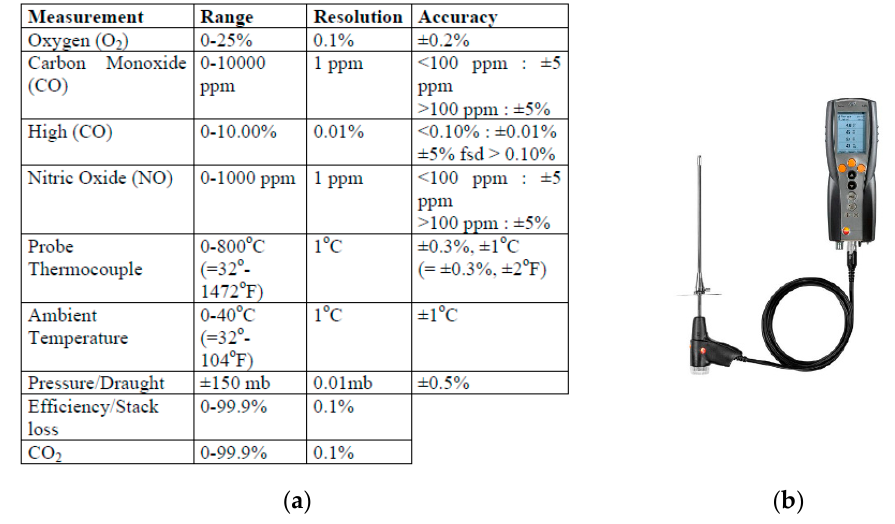
Figure 13. Properties of Tempest 100 gas analyzer [54]; ( a ); Testo 340 gas analyzer ( b ) [55].